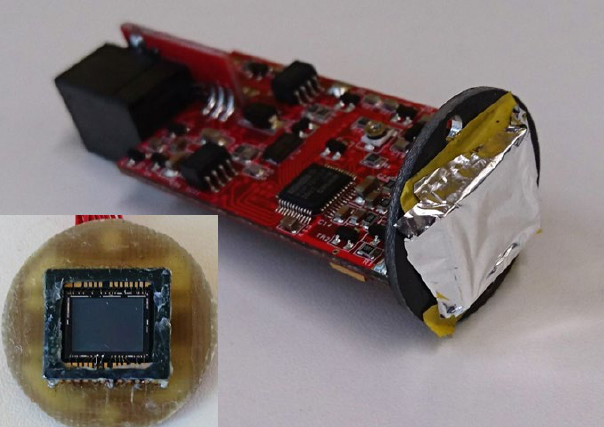
Fig. 3. (cid:302)-particle detection device used in this research showing the CCD covered with Mylar film and the associated electronics. Inset: Uncovered